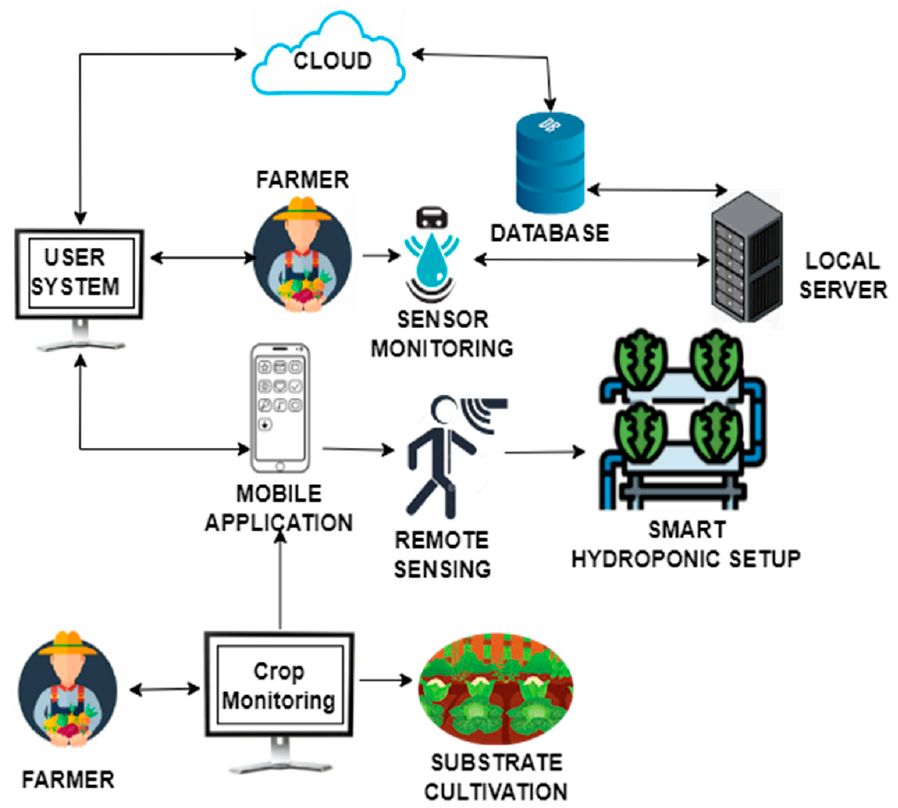
Figure 7. Remote sensing of smart agriculture using the IoT.